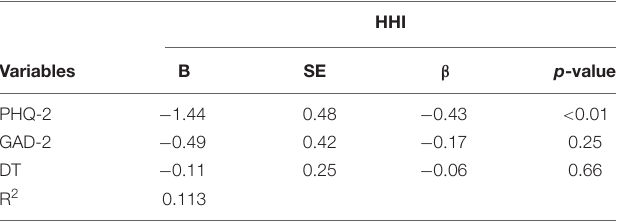
frequently female ( p = 0.006) compared with higher-grade brain tumor patients ( Table 2